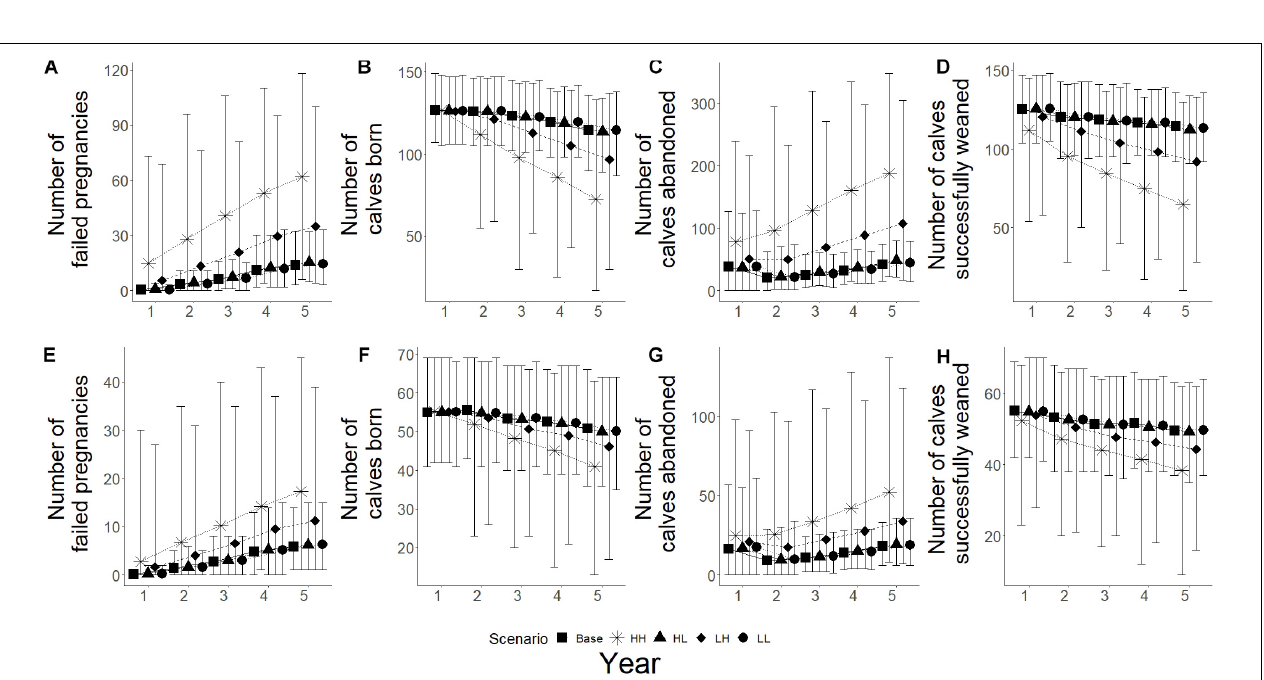
); and a low (cid:32)